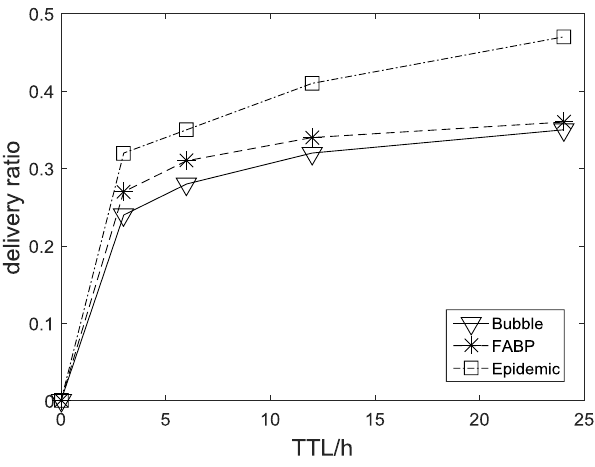
Figure 7. Comparison of the delivery ratio under different TTL values.